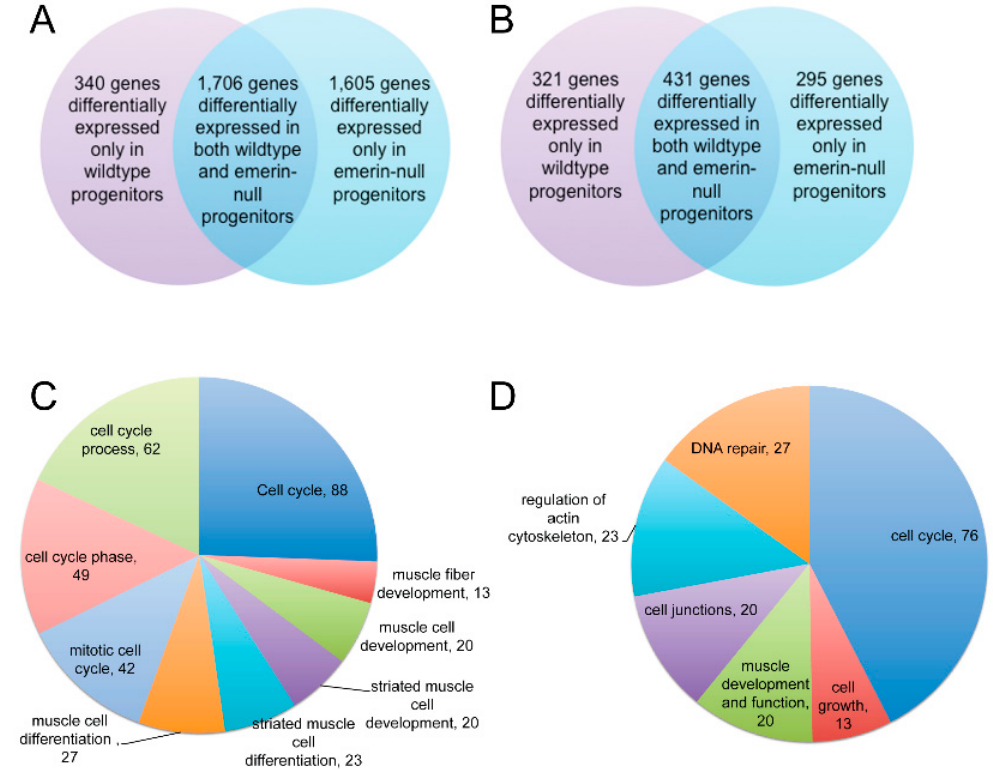
Figure 4. A large number of differentially expressed genes were present only in differentiating emerin-null or wildtype cells. ( A ) Venn diagram of differentially expressed genes during the transition from differentiation day 0 to day 1 showing transcripts differentially expressed in both wildtype and emerin-null cells or differentially expressed only in differentiating wildtype or emerin-null cells. ( B ) Venn diagram of differentially expressed genes during the transition from differentiation day 1 to day 2 showing transcripts differentially expressed in both wildtype and emerin-null cells or differentially expressed only in differentiating wildtype or emerin-null cells. ( C ) Pie Chart showing distribution of significant gene ontology (GO)-terms comparing wildtype and emerin-null cells in the transition from day 0 to day 1 of differentiation derived from DAVID analysis of differentially expressed genes unique to emerin-null cells. ( D ) Pie Chart showing distribution of significant GO-terms comparing wildtype and emerin-null cells in the transition from day 1 to day 2 of differentiation derived from DAVID analysis of differentially expressed genes unique to emerin-null cells .